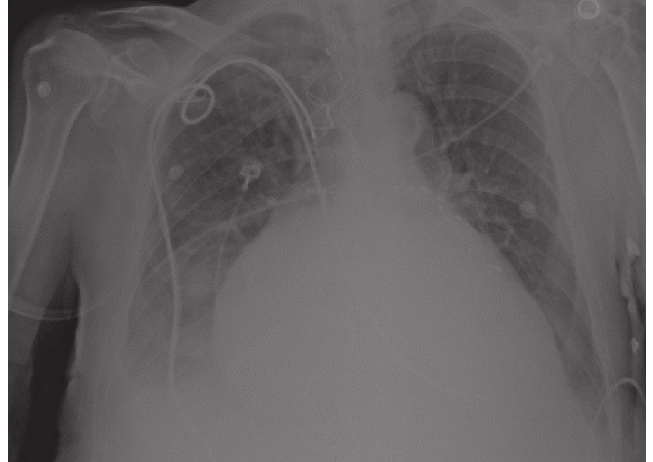
Fig. 6 Sheng Chen and Yuantao